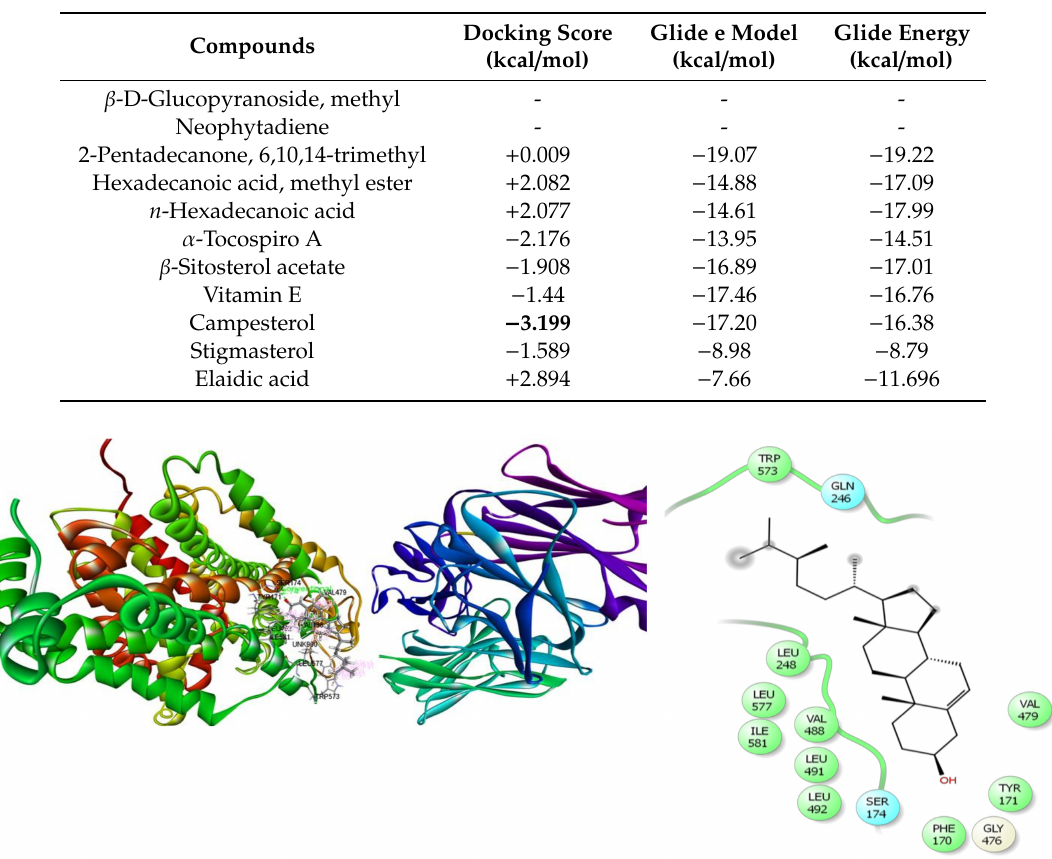
Figure 8. Best ranked poses and 2D interactions of campesterol with human serotonin receptor (pdb: 5I6X) for antidepressant activity.